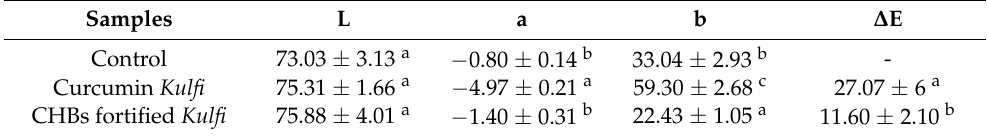
Table 2. Colour parameters of Kulfi fortified with CHBs 1